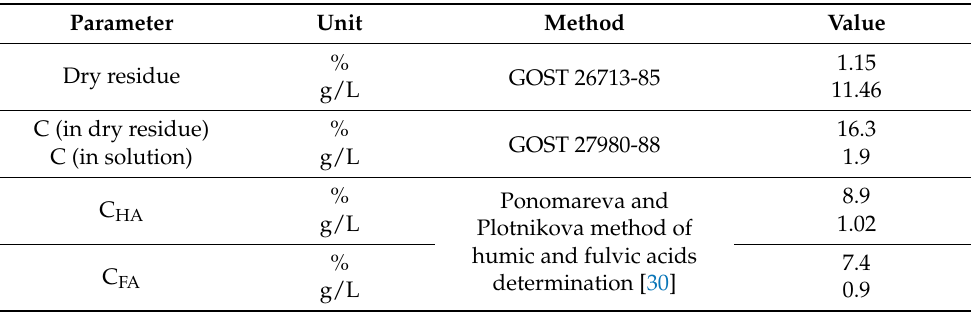
Table 3. The results of the chemical analysis of the BIO-Don10 humic preparation, manufacturer BIO-Don